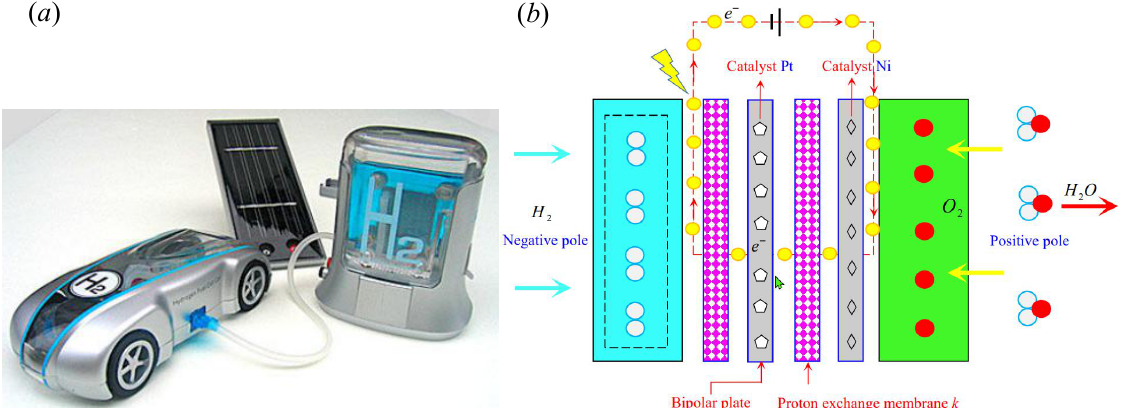
Figure 5. Application and internal power generation process of hydrogen fuel cells. ( a ) Schematic Fig.1 Application and internal power generation process of hydrogen fuel cells. Fig. ( a ). diagram of liquid hydrogen for new energy vehicles powered by hydrogen fuel cells. ( b ) Internal structure and power generation process of hydrogen fuel